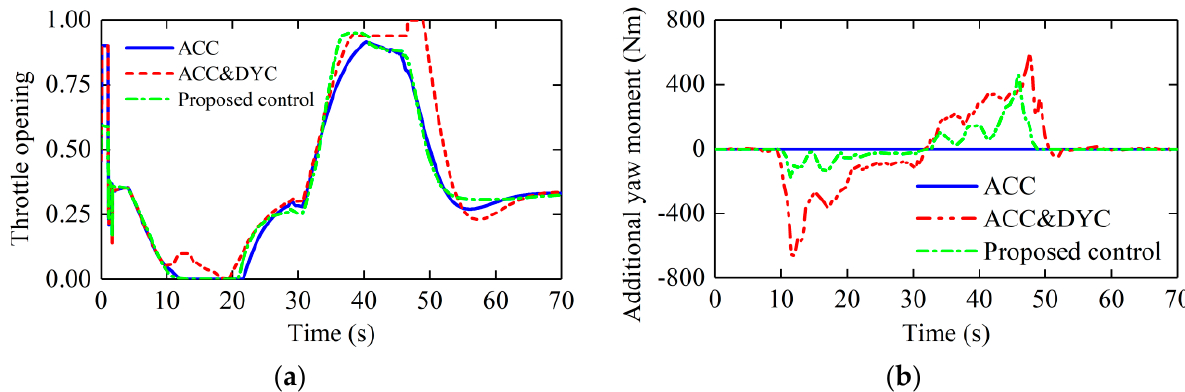
Figure 18. Control outputs: ( a ) throttle opening; ( b ) additional yaw moment.